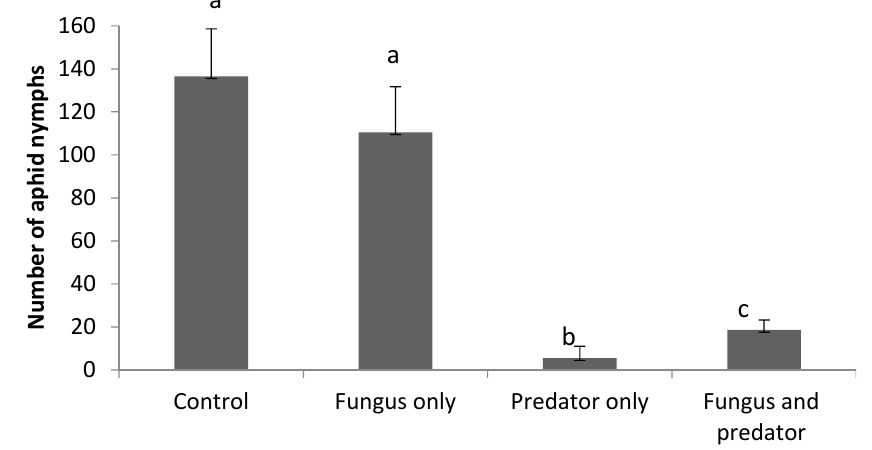
Figure 3. Comparison of the numbers ( ± SE) of living R. padi nymphs at the end of the study between treatments treated or untreated with A. aphidimyza ( n = 40) and M. brunneum . Letters above columns indicate significant ( p < 0.05) differences among